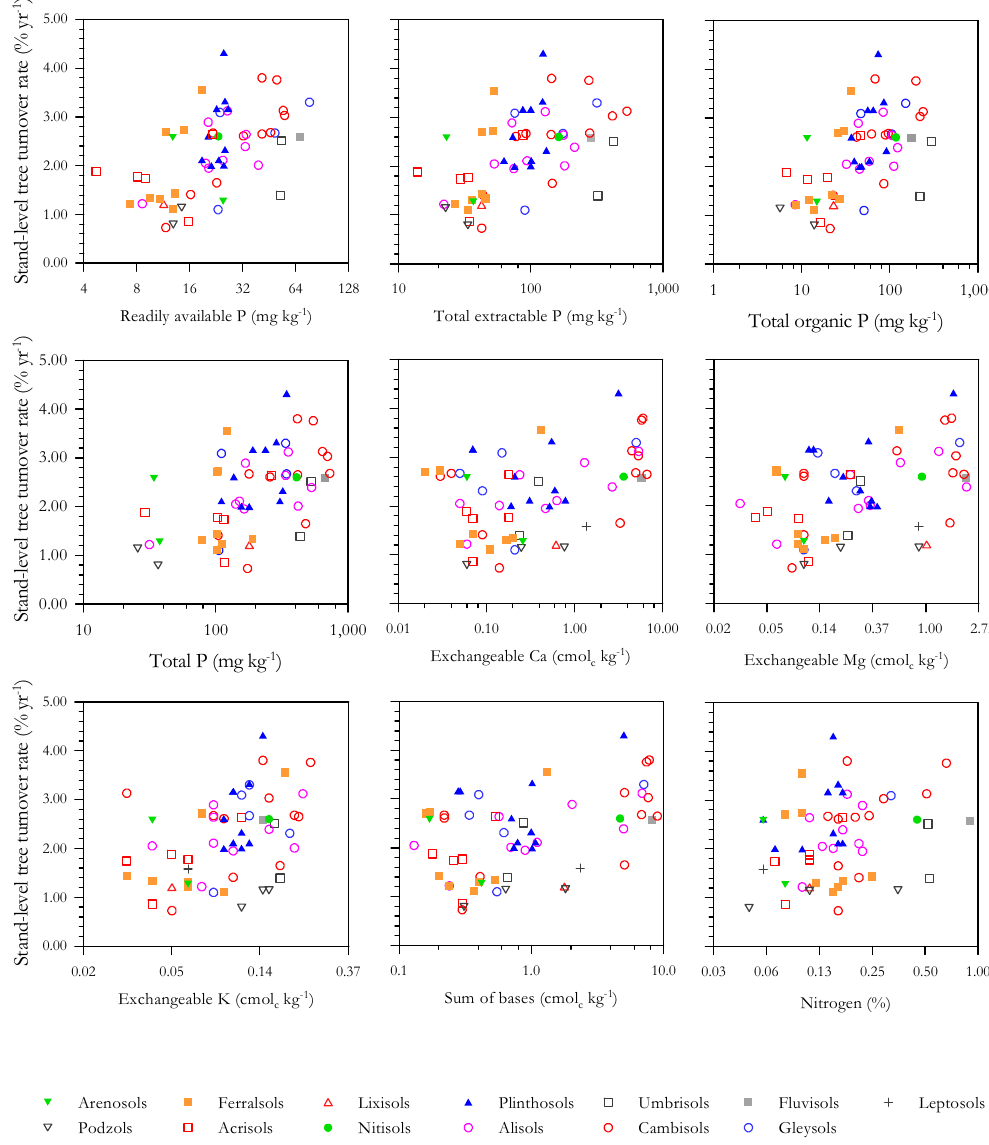
Fig. 9. Relationships between tree turnover rates and different soil fertility